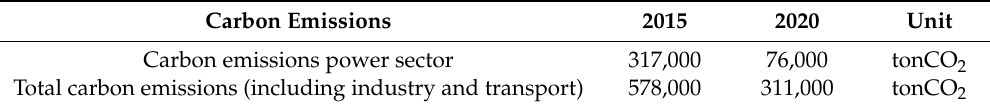
Table 6. CO 2 emissions in the energy